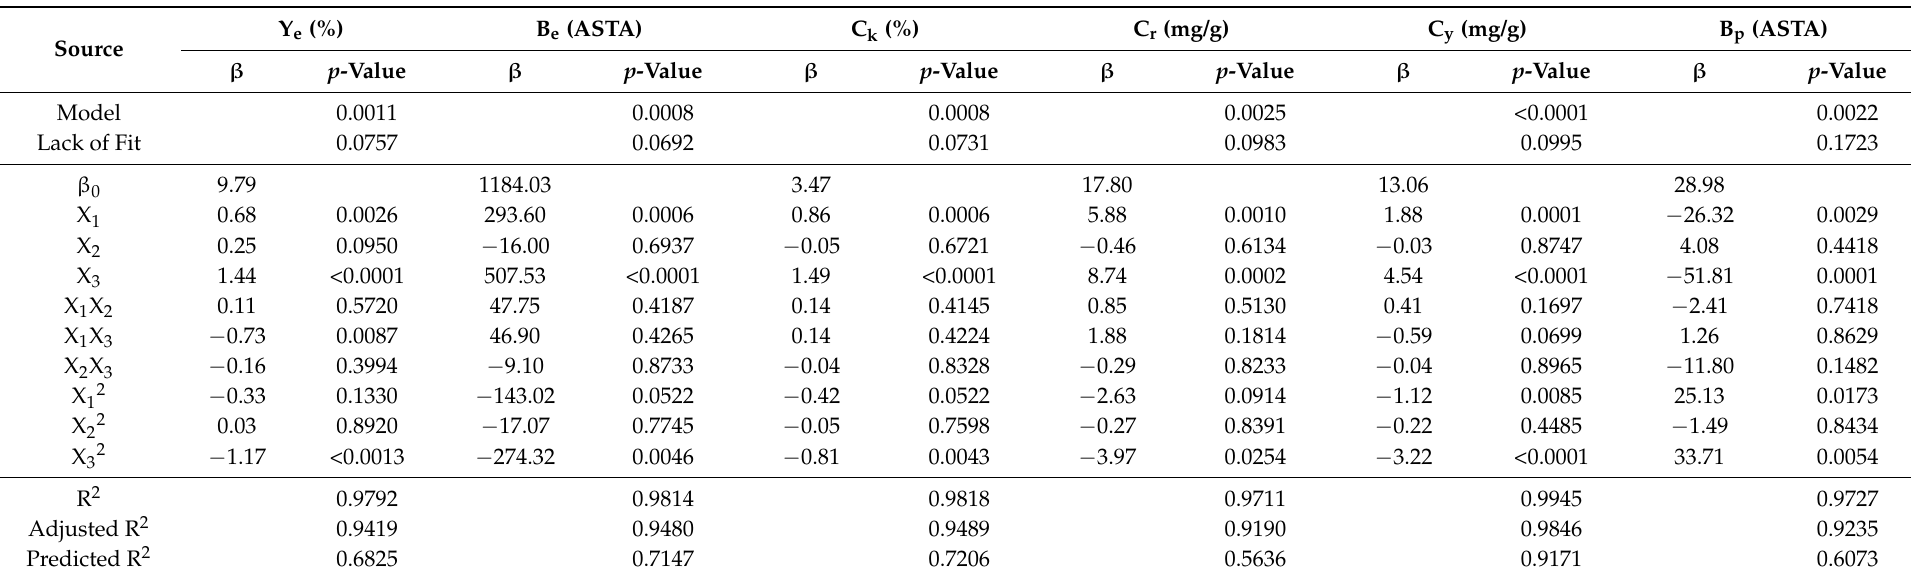
Table 2. Regression coefficients for full quadratic model and model